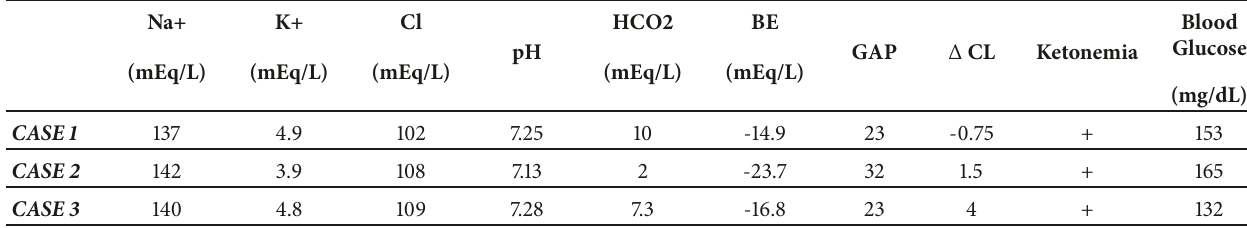
Table 1: Patients’ laboratory results upon admission to the